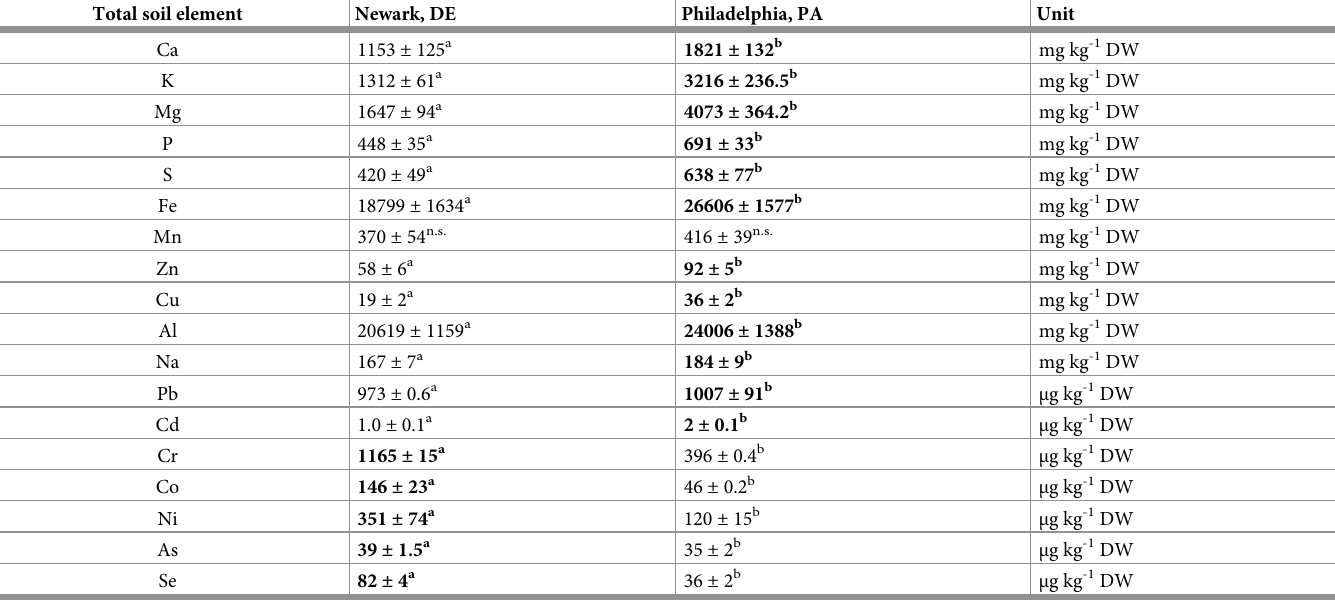
Table 4. Sub-canopy soil total element concentrations for the upper 0–10 cm soil horizon of 77 red maples in ten forests in Newark, DE and Philadelphia, PA. Total soil element Newark, DE Philadelphia,